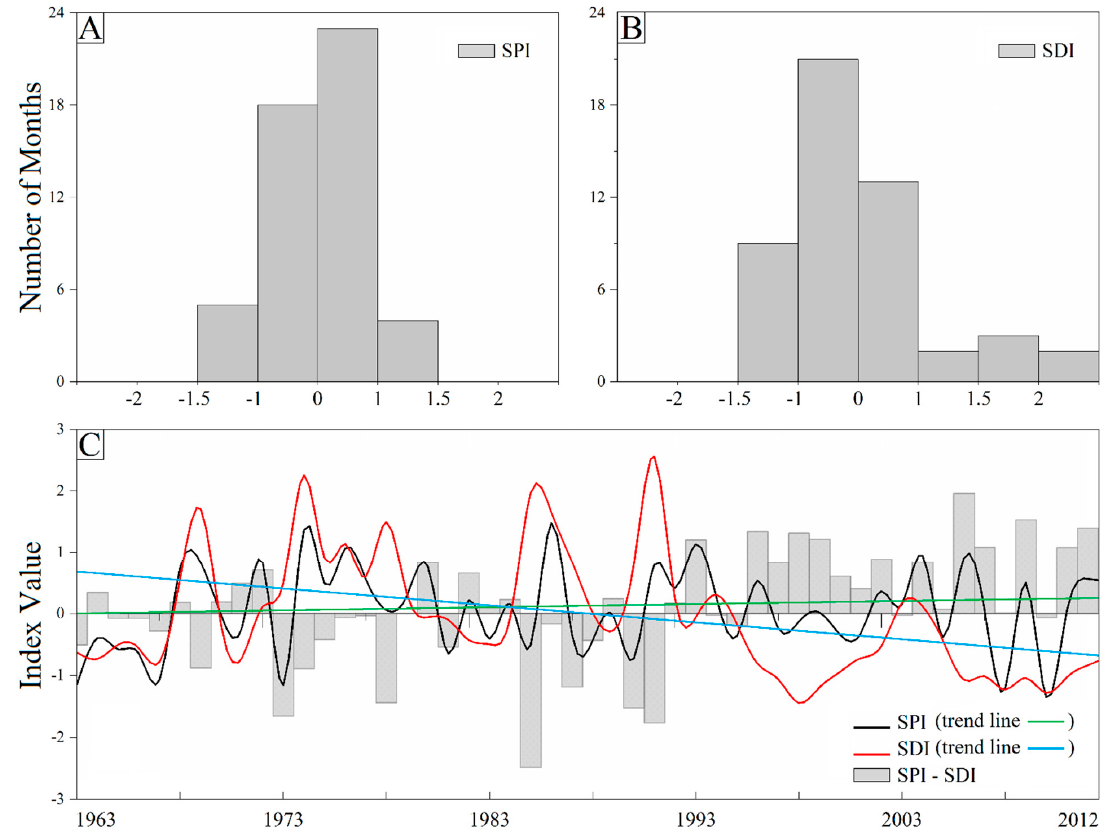
Figure 2. Time series of index values over the interval from 1963 to 2012, in the Zayanderud Basin. ( A ): the standardized precipitation index (SPI), annual values distribution. ( B ): the streamflow drought index (SDI) annual value distribution. ( C ): The annual SPI, SDI and SPI–SDI values between 1963 and 2012.